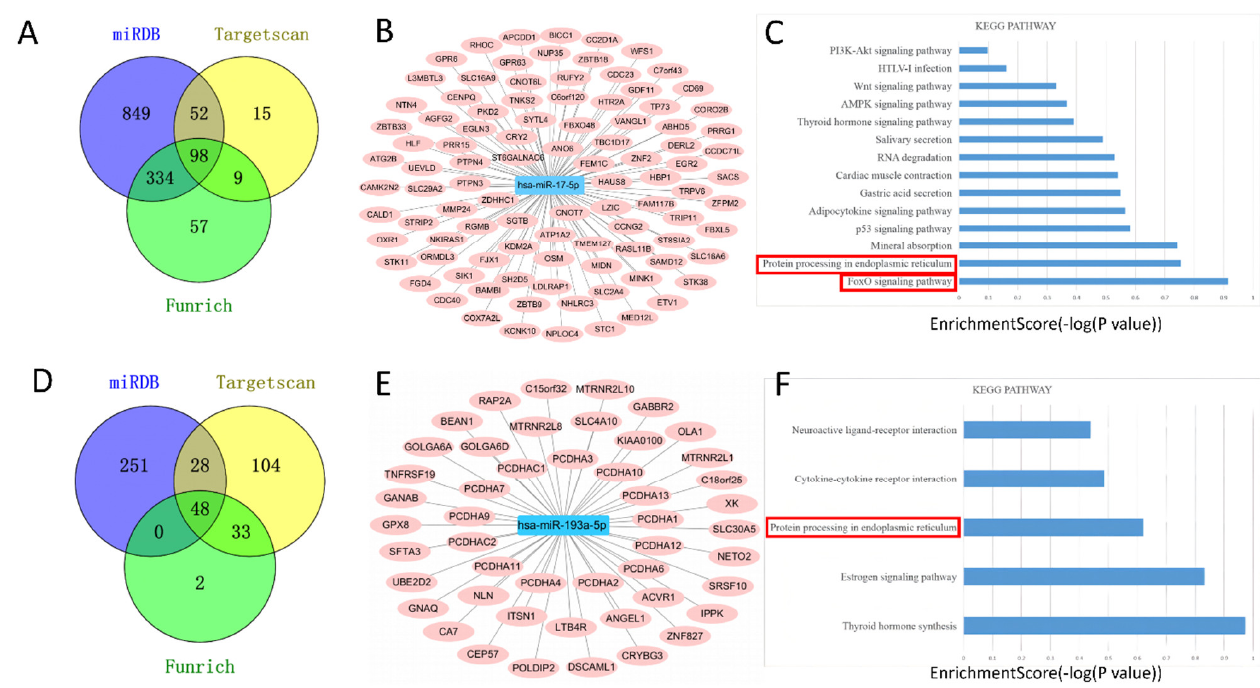
Figure 5. MiRNAs target prediction and pathway analysis. TargetScan, Funrich, and miRDB were used to predict downstream target genes of miR−17−5p ( A ) and miR−193a−5p ( D ). Construction of miR−17−5p ( B ) and miR−193a−5p ( E ) centered target gene regulatory network. KEGG analysis of the